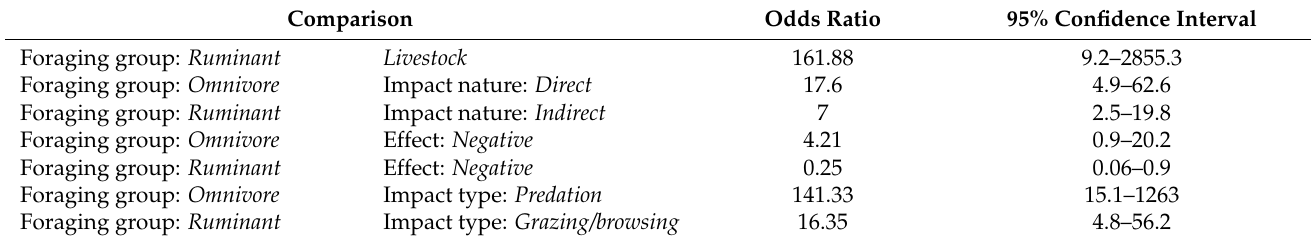
Table 4. Odds ratios and their 95% confidence intervals of the specific combinations of domestication status, nature and outcome of impact, ungulate impact type vs. ungulates categories based on their digestive system and foraging